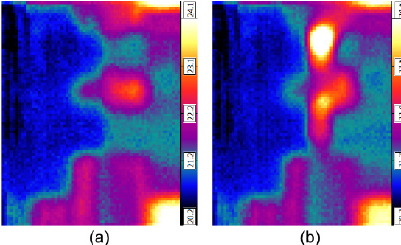
Fig. 8. The infrared images before and after the impact (the interframe time is 189